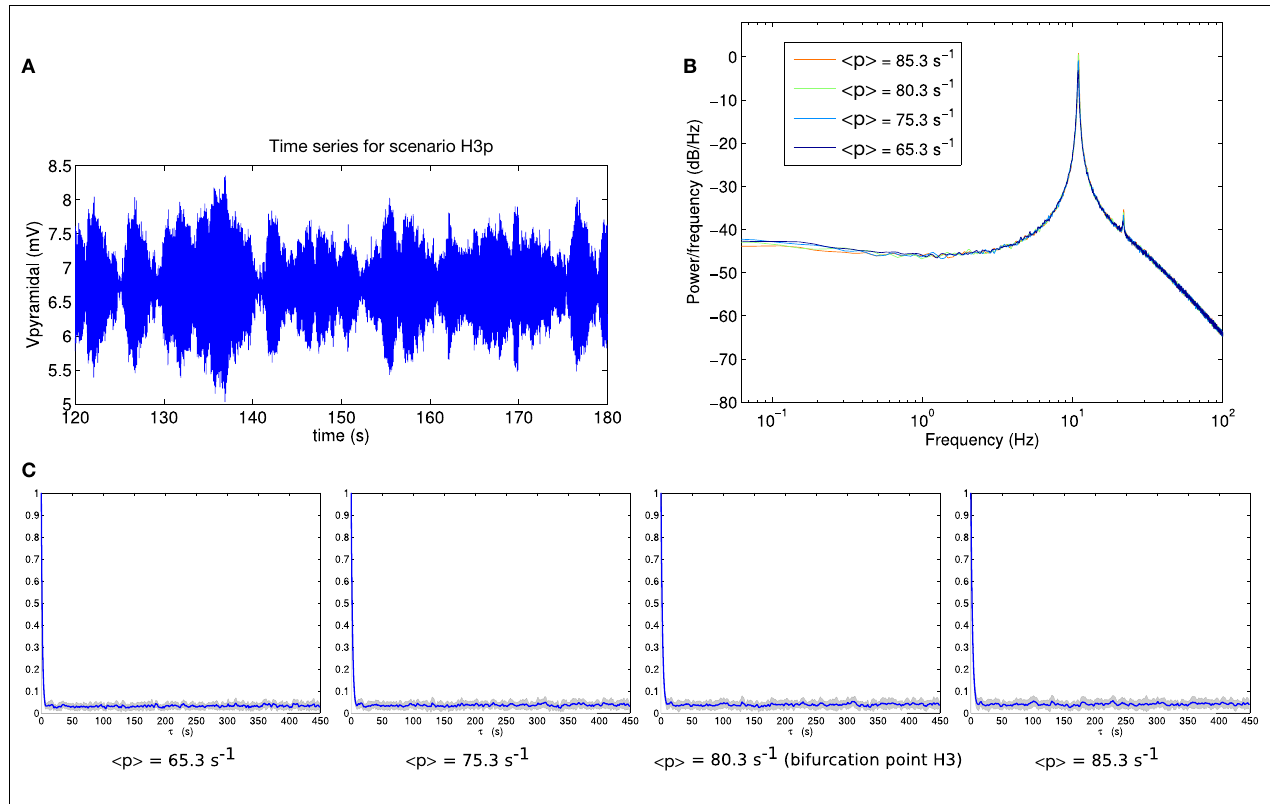
< p > = 75.3s − 1 ) at the bifurcation point H3 (< p > = 80.3s − 1 ) and beyond the bifurcation point (< p > = 85.3s − 1 ).The line indicates the mean over 16 trials and the gray area indicates one standard